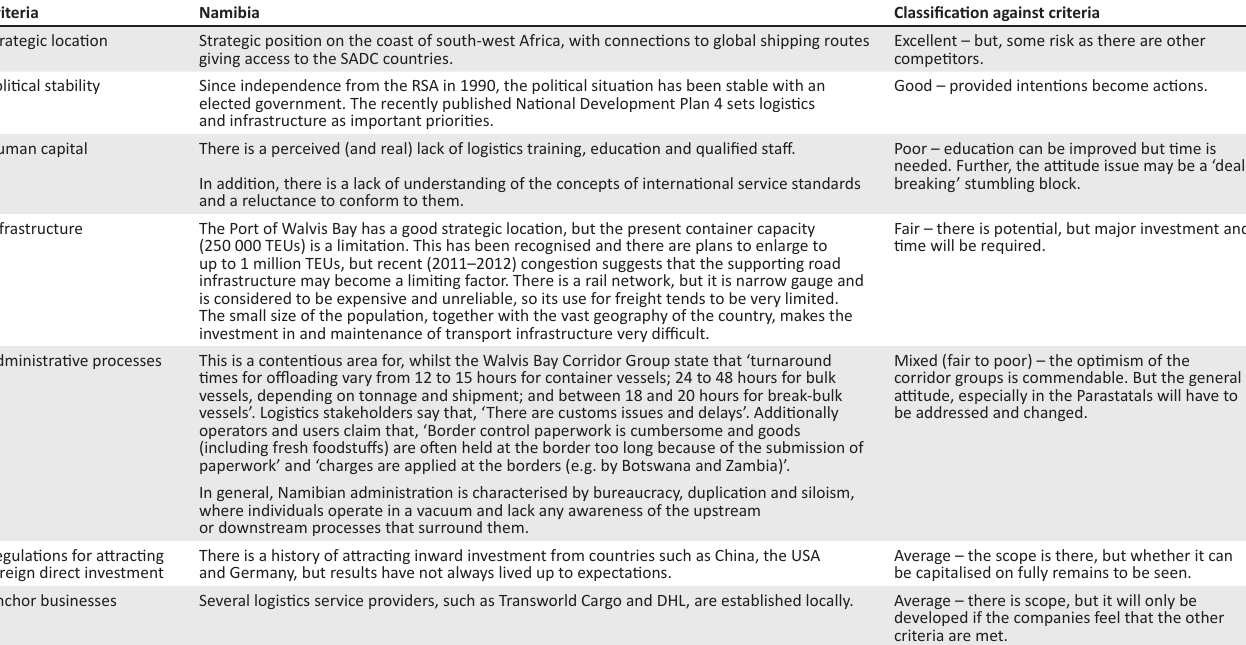
TABLE 2: Applying to Muñoz and Rivera’s criteria for logistics cluster success to Namibia.